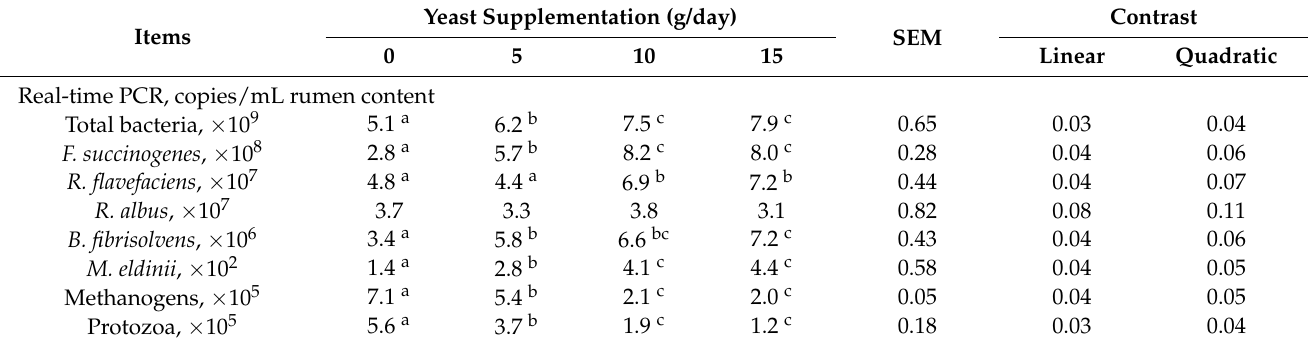
Table 5. Effect of yeast supplementation in high concentrate diet on microbial population in fattening steers.